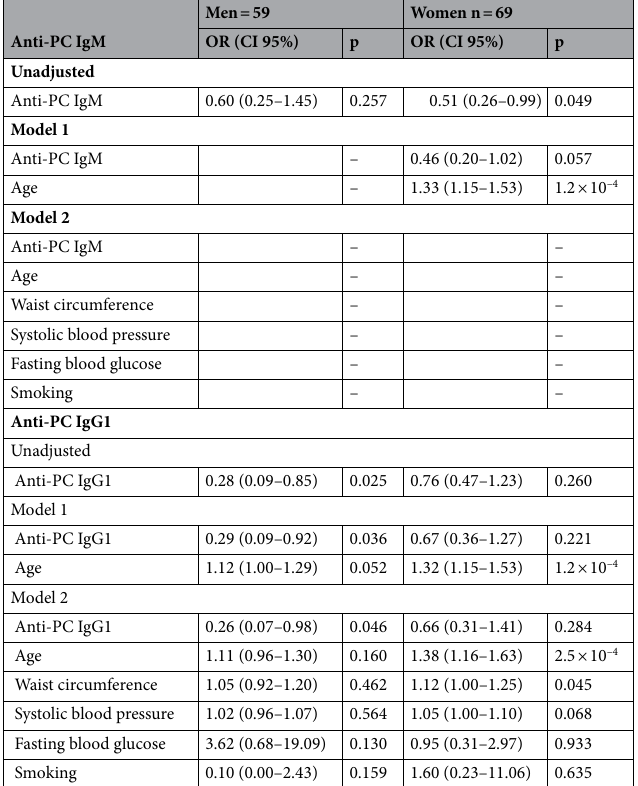
Table 3. Sex-specific associations between anti-PC and risk of being a hospitalized obese subject (HO). Values are odds ratios (OR) with 95% confidence intervals (CI 95%). MetS metabolic syndrome, anti-PC antibodies